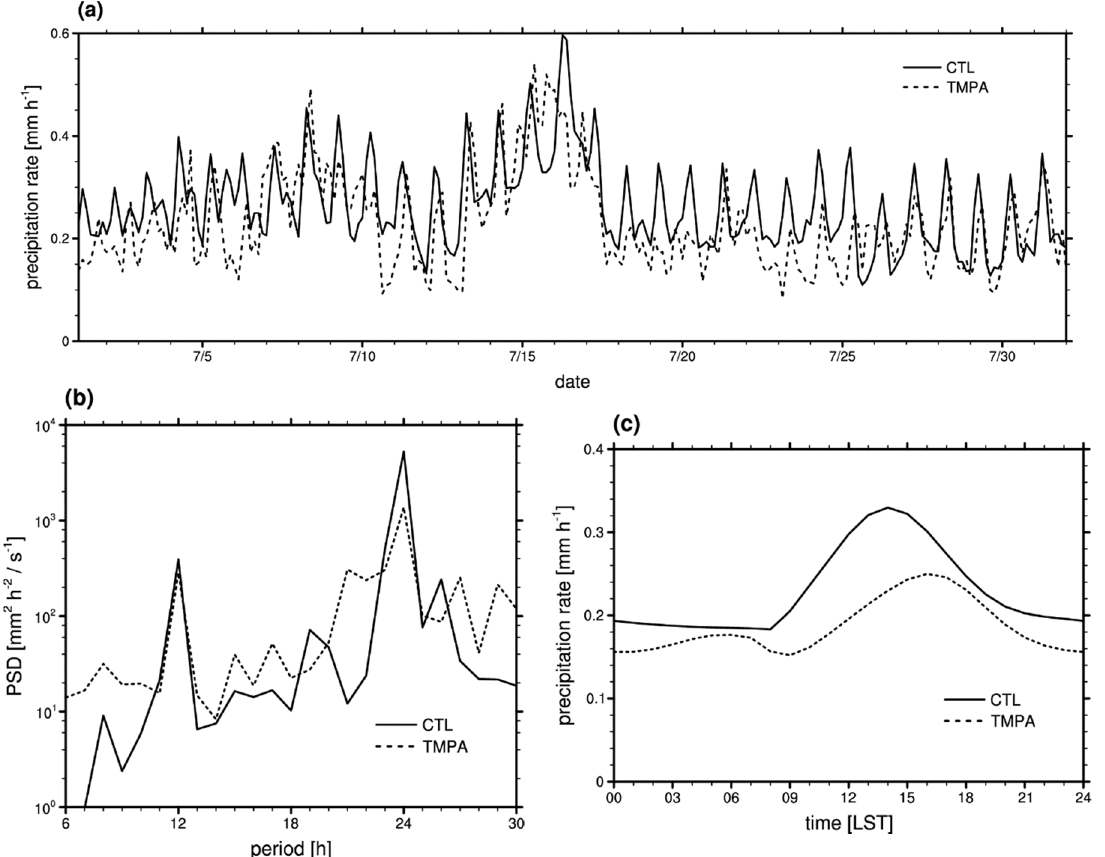
Figure 2. ( a ) Time series of spatially averaged precipitation rate (mm h − 1 ) and ( b ) power spectral density (PSD) of precipitation rate plotted on a logarithmic scale as a function of period (mm 2 h − 2 /s − 1 ) for July 2006, and ( c ) mean diurnal variation of precipitation rate (mm h − 1 ) for JJA 2006 averaged over the East Asian land area from the TMPA observation (dashed lines) and CTL experiment (solid lines). Note that precipitation rate is averaged over all grid points over land shown in Figure 1 at latitudes below 50 ◦ N where the TMPA data are available, and the PSD is averaged across the spectral bins of period with an interval of 1 h.